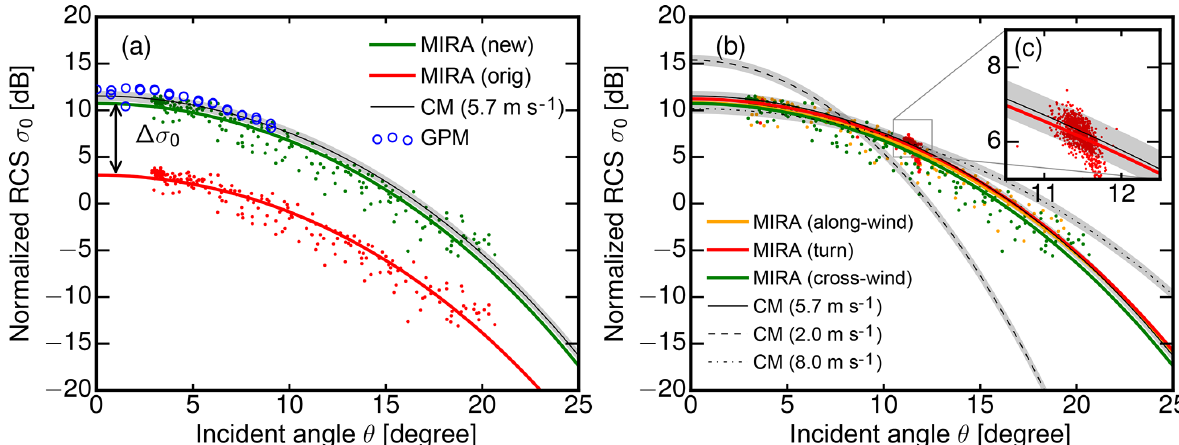
Figure 7. Normalized radar cross section (RCS) σ ∗ of the ocean surface as a function of the radar beam incident angle θ . (a) Falloff of 0 σ ∗ with θ measured with HAMP MIRA (red/green dots) and GPM (blue circles). The HAMP MIRA data are calculated and subsequently 0 fitted using the old, estimated calibration (red line) and the new, measured calibration (green line). The modeled value (CM: Cox–Munk) and uncertainty of σ 0 for the actual measured wind speed from the buoy is shown by the black line and the shaded region. (b) Comparison of measured σ ∗ during the along-wind (orange) and across-wind (green) roll maneuver and during the turn (red). (c) A closer look on the 0 scatter of σ 0 during the turn maneuver, with a standard deviation of